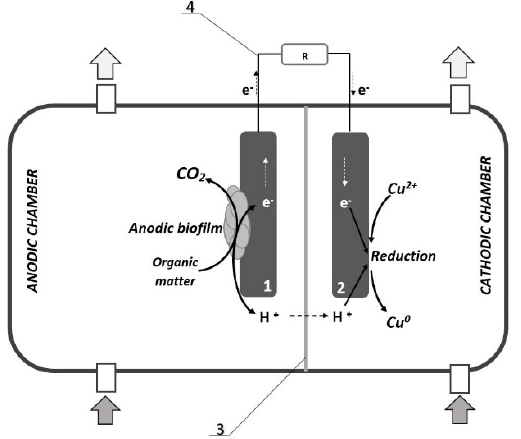
Figure 7. MFC reactor used in the copper removal experiments; 1—anode, 2—cathode, 3—PEM, 4—external circuit and resistor